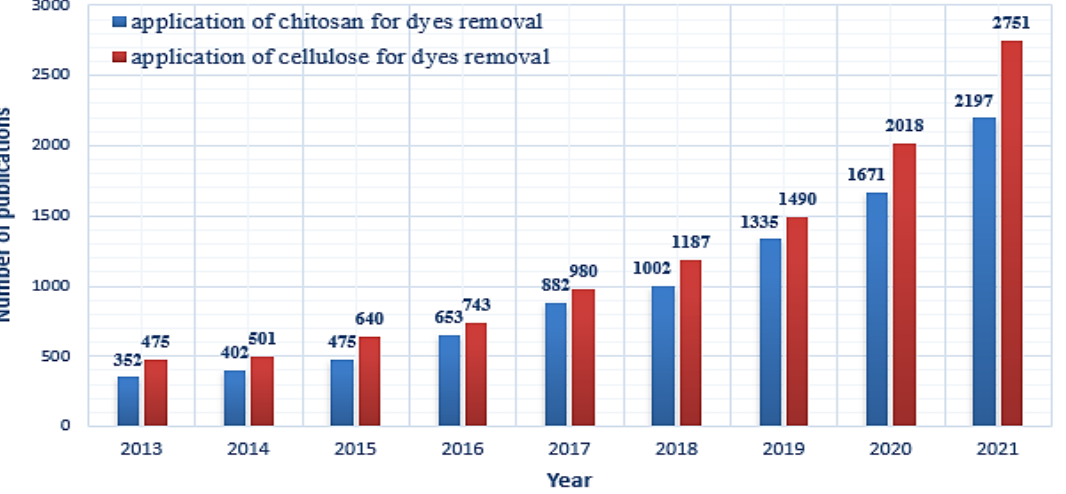
Figure 1. Published papers related to utilization of chitosan and cellulose for dye removal. Obtained from ScienceDirect. Search words, respectively, were chitosan adsorption for dye removal and cellulose adsorption for dye removal.